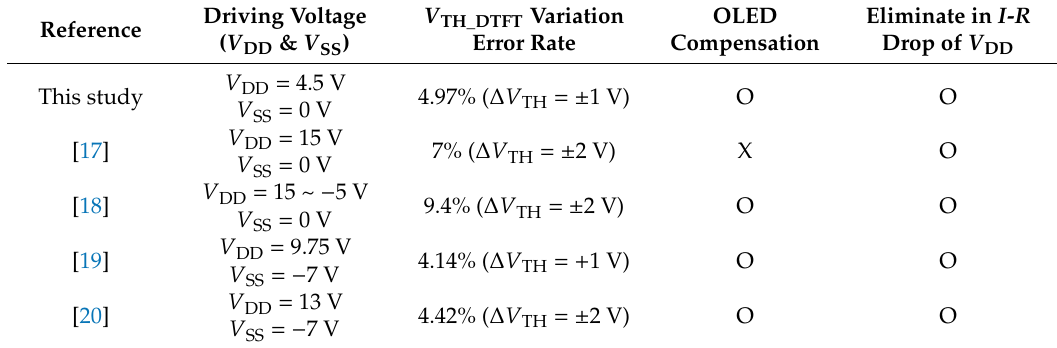
Table 1. Comparison of proposed and prior pixel